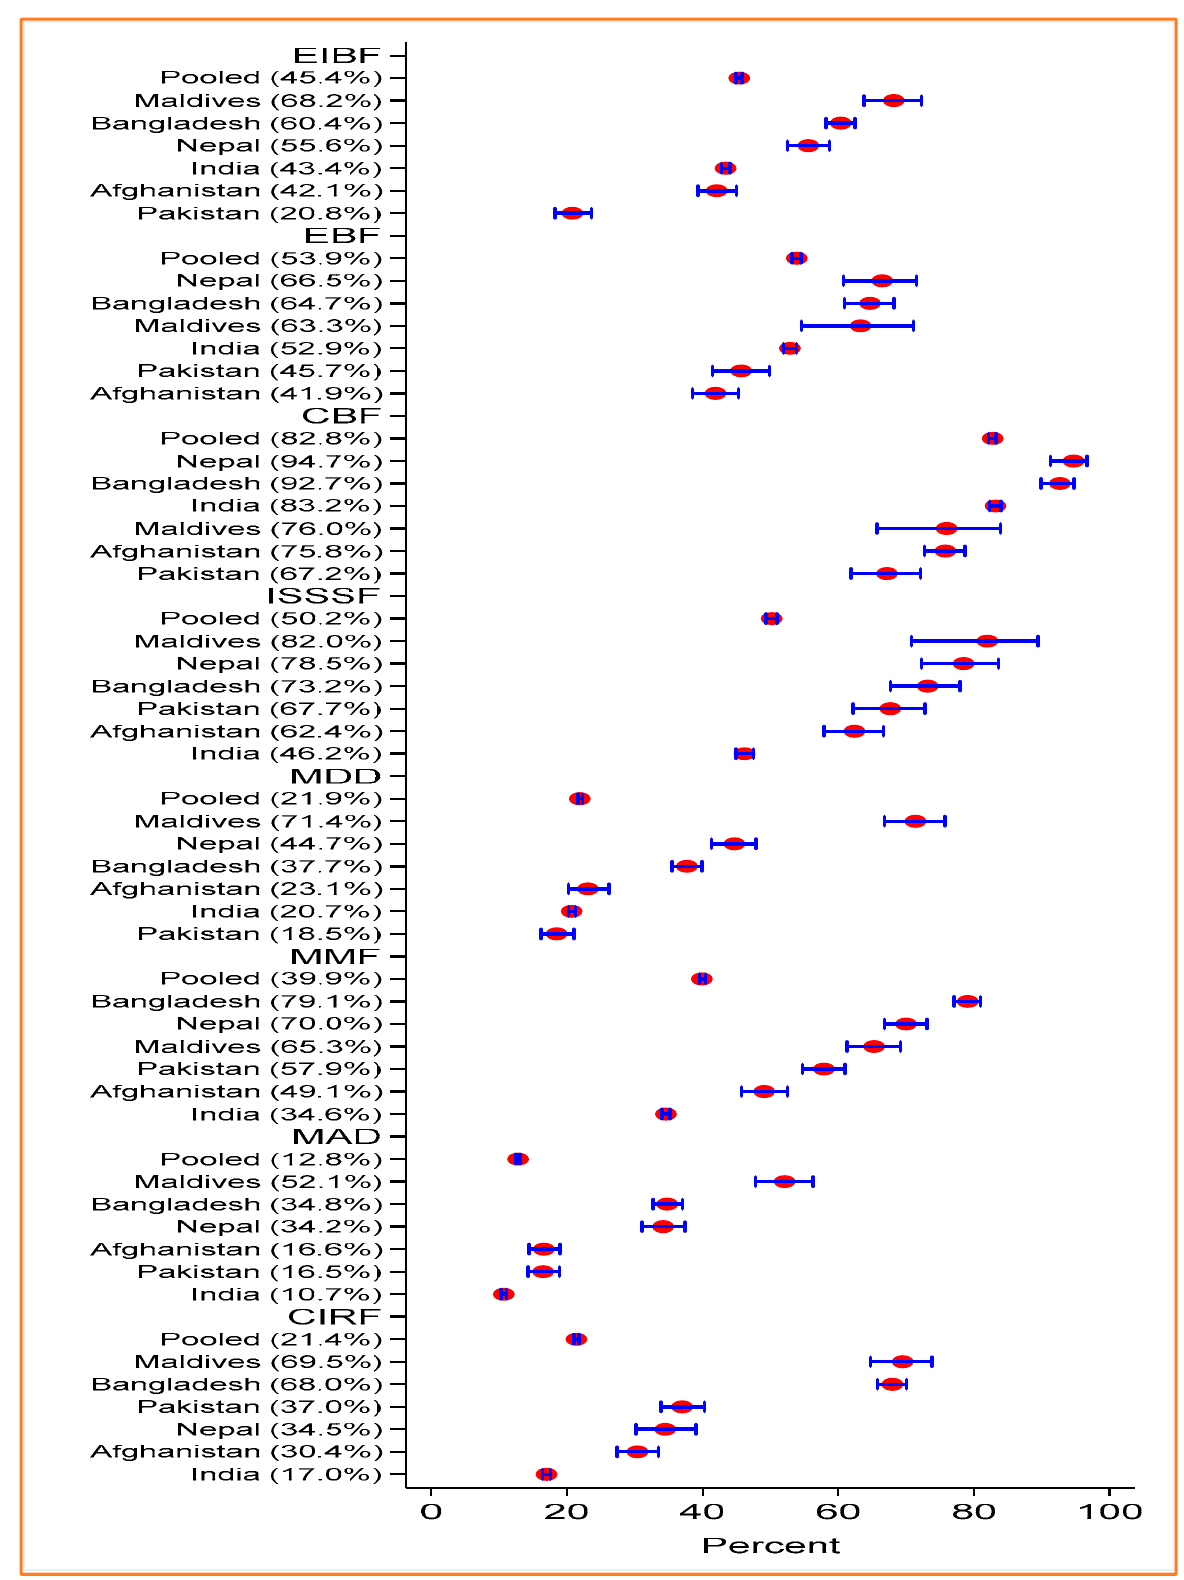
Figure 1. Prevalence of IYCF practices in South Asian countries .